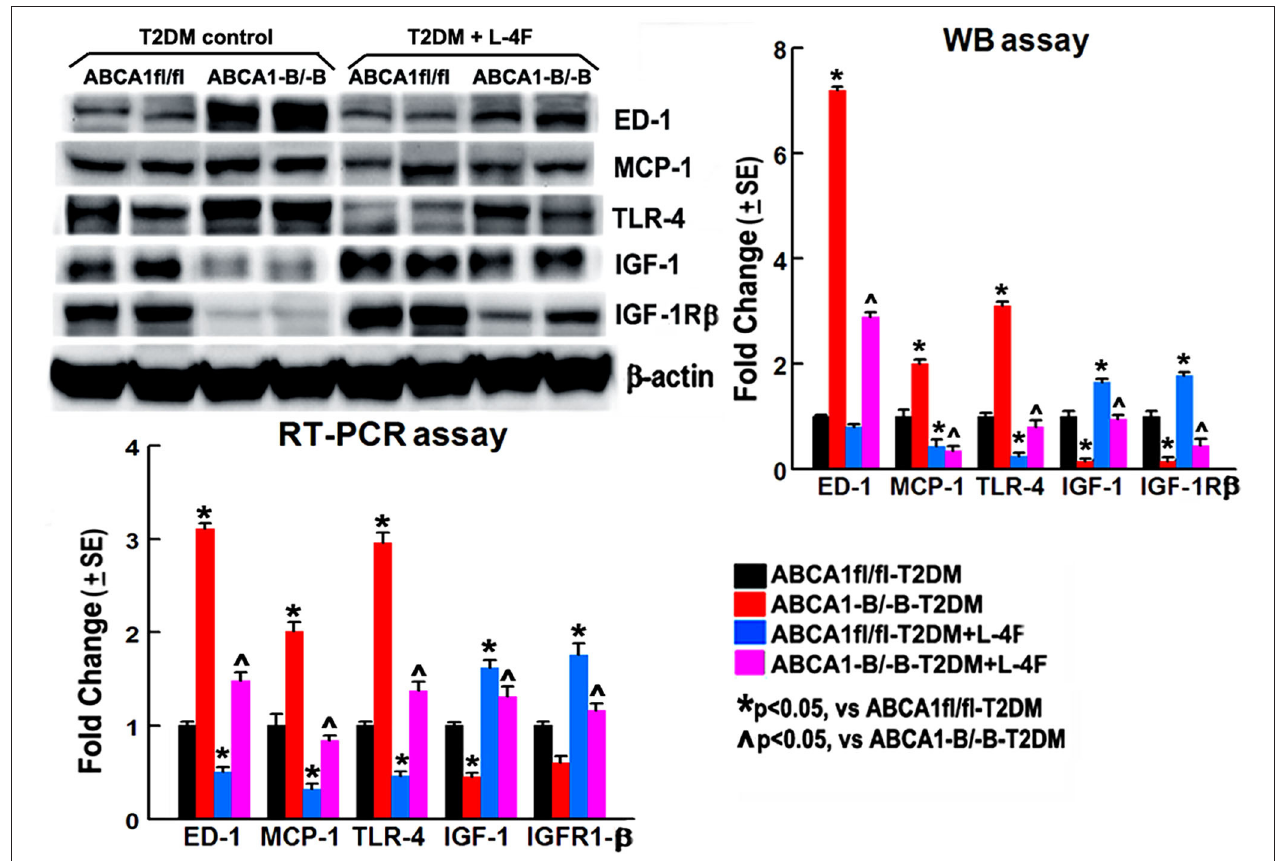
FIGURE 8 | L-4F treatment decreases ED1, MCP-1, and TLR-4 but increases IGF-1 and IFGR-1 β in the ischemic brain in both ABCA1 fl / fl and ABCA1 − B / − B T2DM mice at 21 days after stroke measured by WB or RT-PCR. n =